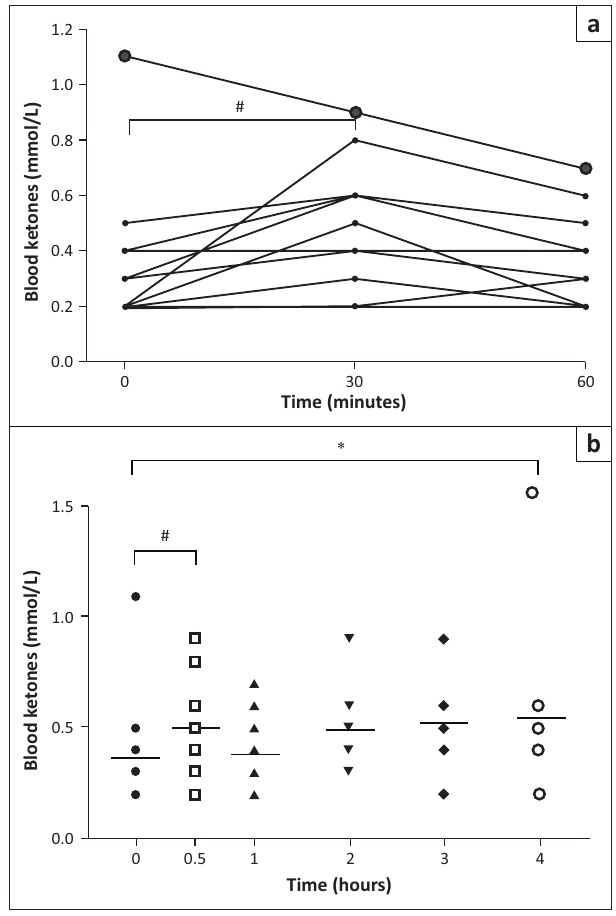
FIGURE 6: Beta-hydroxybutyrate responses to PF. (a) Individual BHB changes (from baseline) at 30 min and 60 min. The magnitude of BHB change at 30 min ranged from -0.2 mmol/L to +0.6 mmol/L. (b) Scatter plot (line at median) of insulin levels at baseline (fasting) and across the 4-h study period. Median (95 % CI) BHB after 30 min had increased from 0.3 mmol/L (0.2 mmol/L–0.5 mmol/L) to 0.5 mmol/L (0.2 mmol/L–0.8 mmol/L). At 4 h, median BHB was 0.45 mM (0.4 mM–0.6 mM). #Indicates significantly increased BHB ( p = 0.02) at 30 min compared to baseline, after exclusion of a single outlier (indicated by open grey circles in a). * Indicates whole-group significant increase in BHB at 3h and 4 h compared to baseline ( p = 0.3 and p = 0.002,